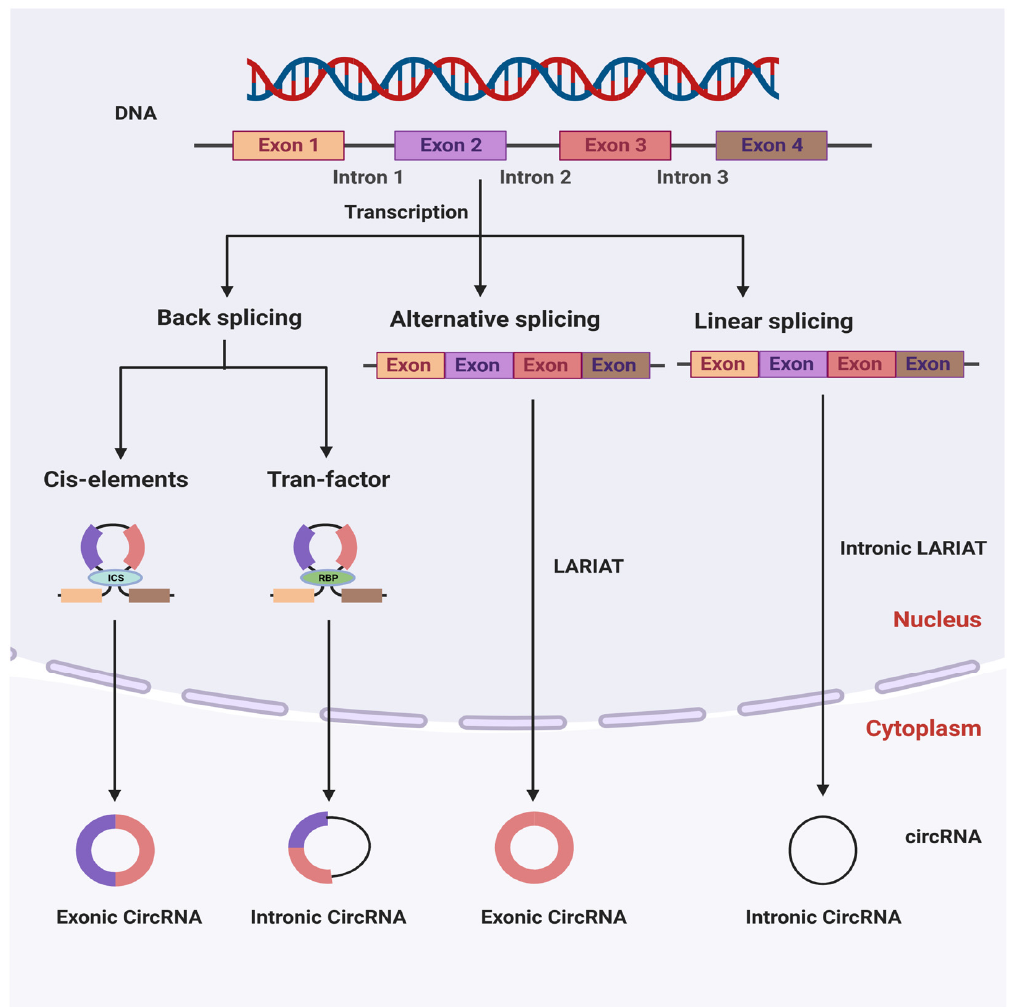
Figure 1. The molecular mechanisms of circular RNA biosynthesis and their classification in a cell. ICSs (intronic complementary sequences) and RBPs (RNA-binding proteins) modulate the production of circRNA.